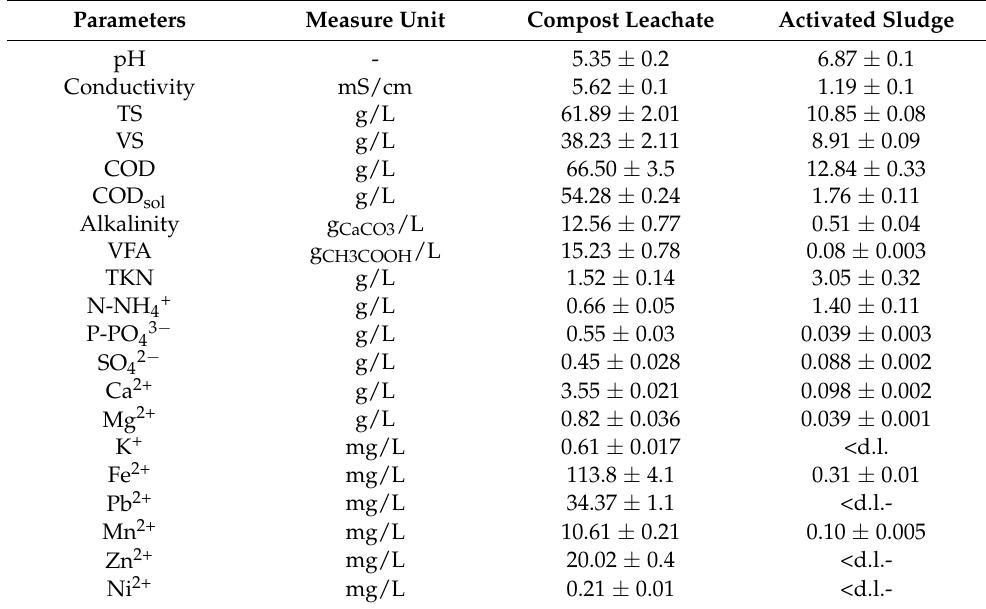
Table 1. Characteristics of raw compost leachate and activated sludge (d.l. detection